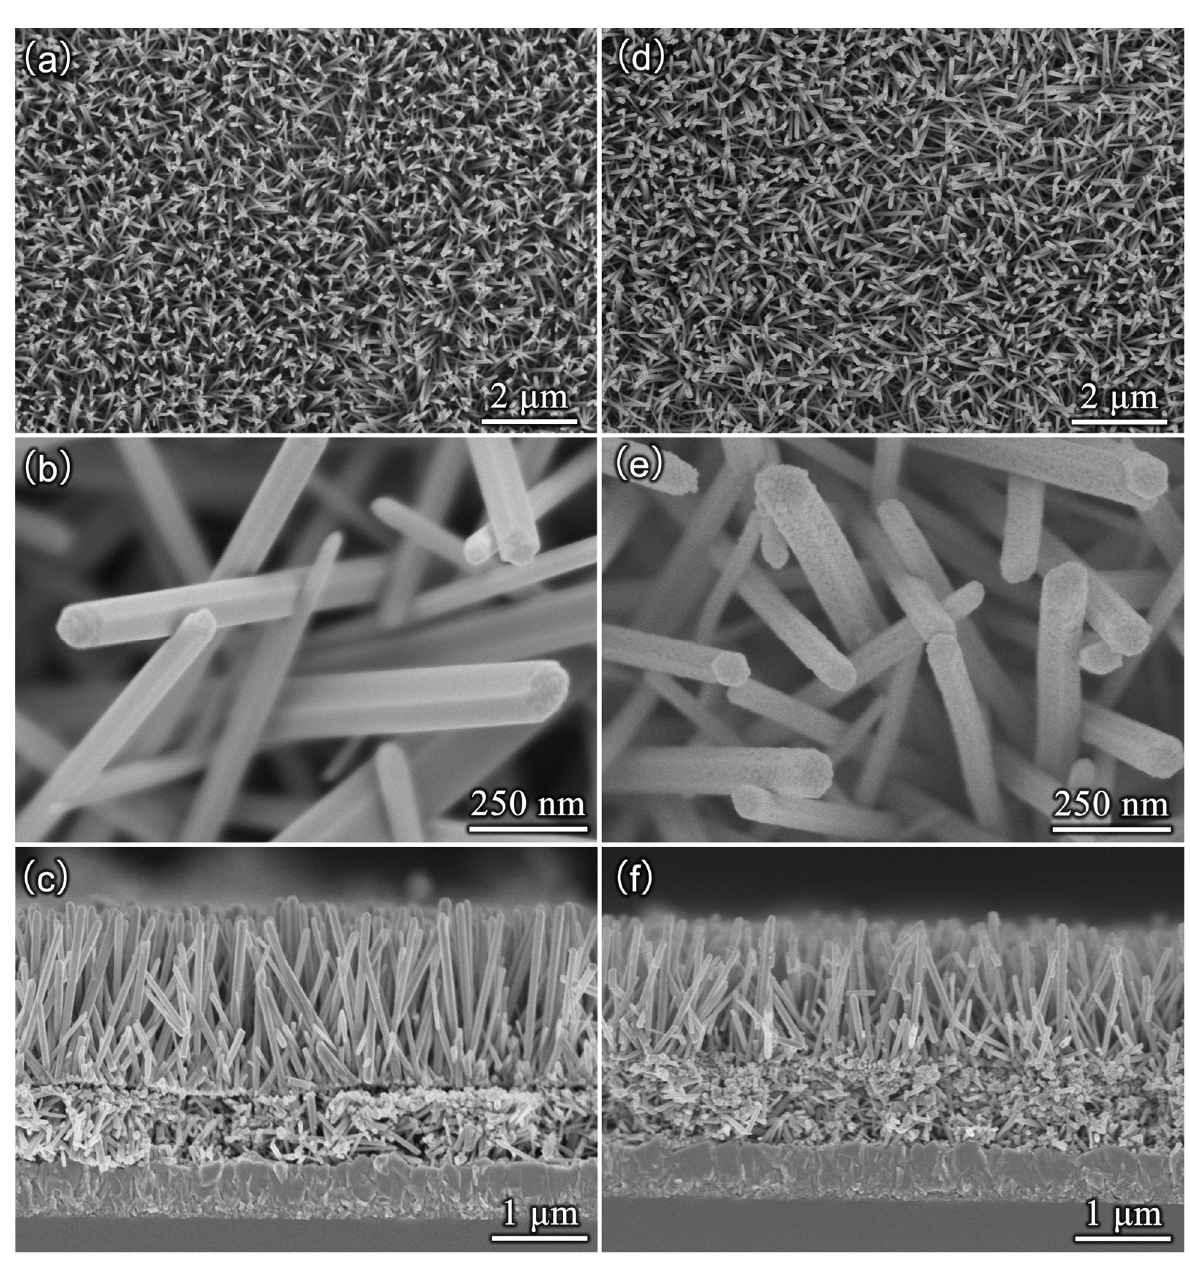
Figure 2. Top ‐ view and cross ‐ sectional view of SEM images: ( a – c ) ZnO and ( d – f ) ZnO/Bi 2 S 3 pho ‐